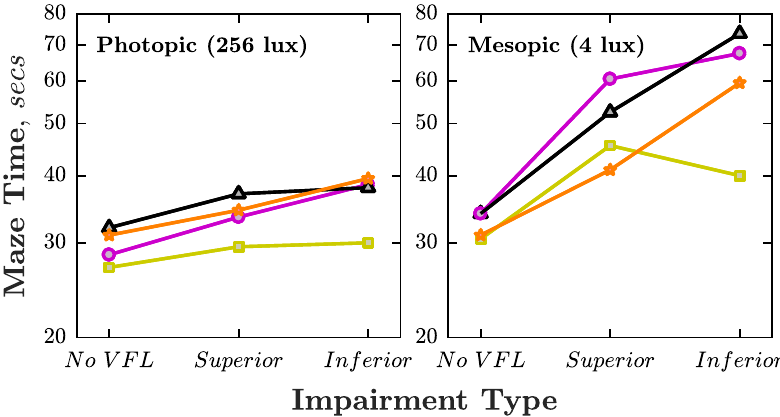
Fig. 6 Performance on AR visual. Panels show maze completions times under a Photopic and b Mesopic lighting conditions. Each line indicates a single participant (same individuals in both conditions).